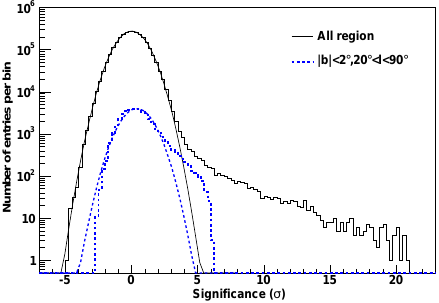
Figure 1: Significance distribution of the whole sky map (thick solid line). The thin solid line represents the best Gaussian fit. The significance distribution of the Galactic Plane region with | b | < 2 ◦ and 20 ◦ < l < 90 ◦ is shown by the thick dotted line. The thin dotted line represents the best Gaussian fit for the same